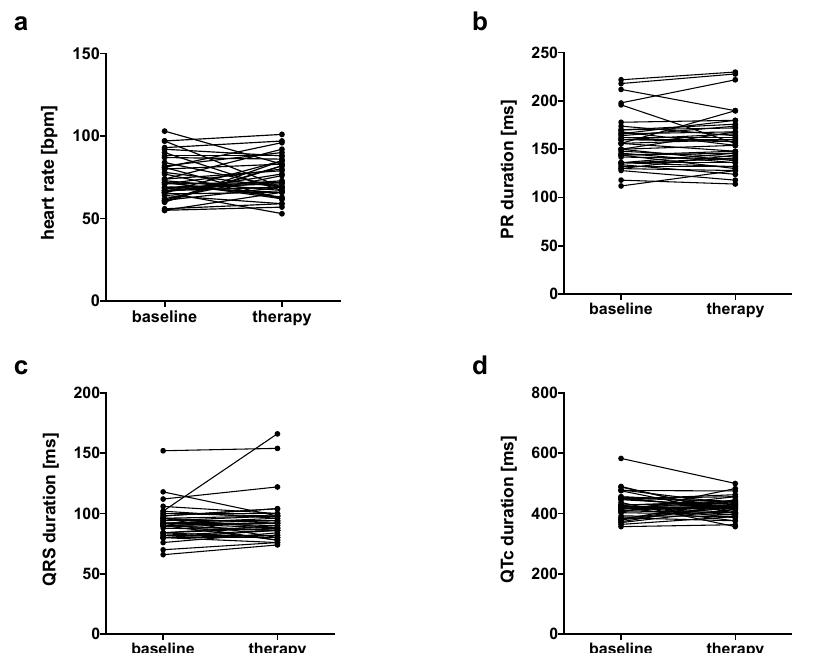
Figure 1. There were no changes in ( a ) heart rate, ( b ) PR duration, ( c ) QRS duration and ( d ) Duration of the corrected QT interval (QTc) comparing values before and during anti-cancer therapy.